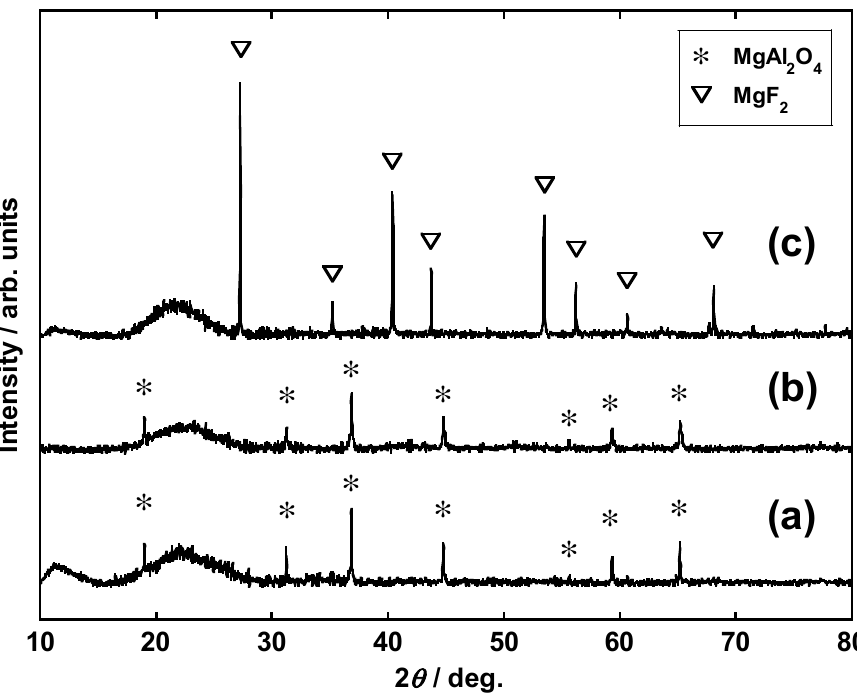
Figure 8. XRD profiles of the residues obtained under conditions ( a ) II-A, ( b ) II-B, and ( c ) II-C. Dissolution conditions: 12 M HCl at 180 °C for 2 h.